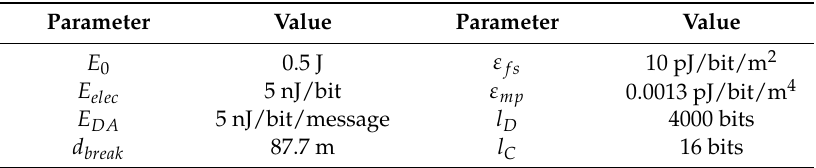
Table 1. General parameters for